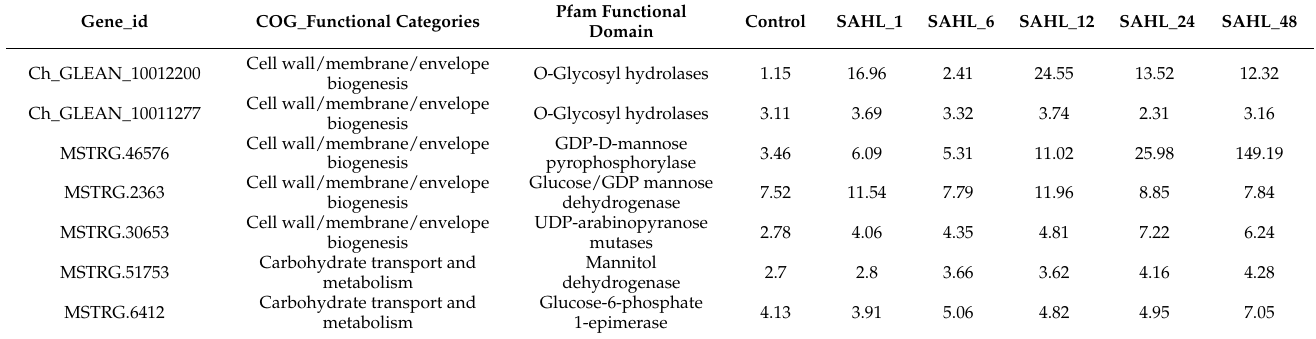
Table 2. The genes involved in both the cellulose and mannose development pathways and their expression level of FPKM in H. pluvialis in this